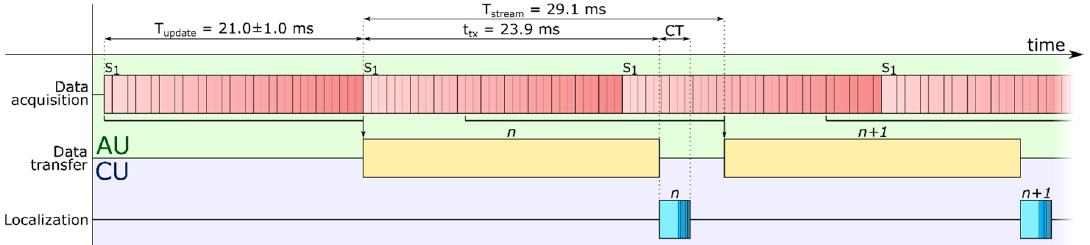
Figure 2. Temporal diagram of the tasks involved in the embedded localizer. The acquisition unit (AU) continuously samples the data from the sensor matrix (21.0 ± 1.0 ms update period) and transfers (taking 23.9 ms) the latest acquired data package to the computation unit (CU) every 29.1 ms, and subsequently starts acquiring the n th + 1 package. The CU localizes each data package in CT (computation time) seconds.